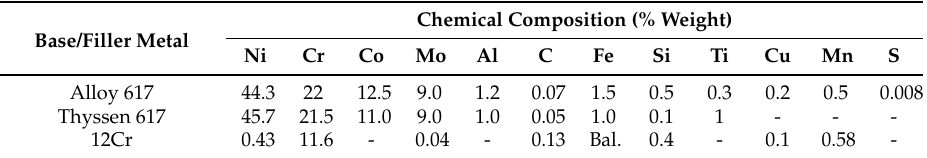
Table 1. Chemical compositions of Alloy 617, Thyssen 617, and 12Cr steel.